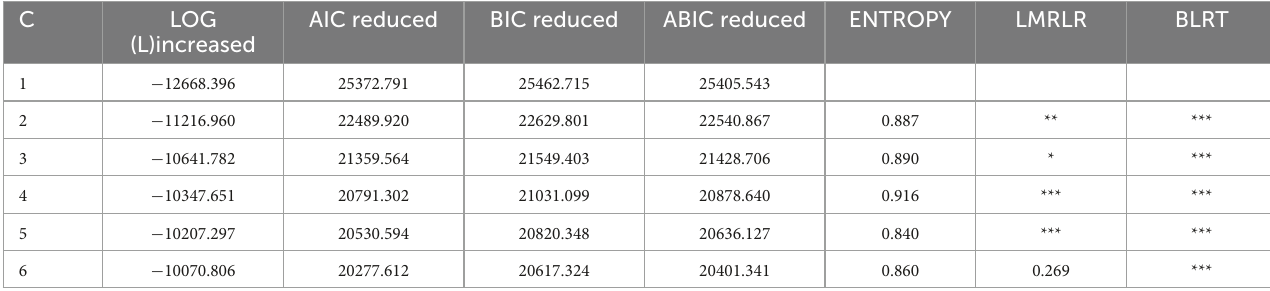
TABLE 2 Six latent structure model fit indices of college students’ sports behavior motivation ( N =